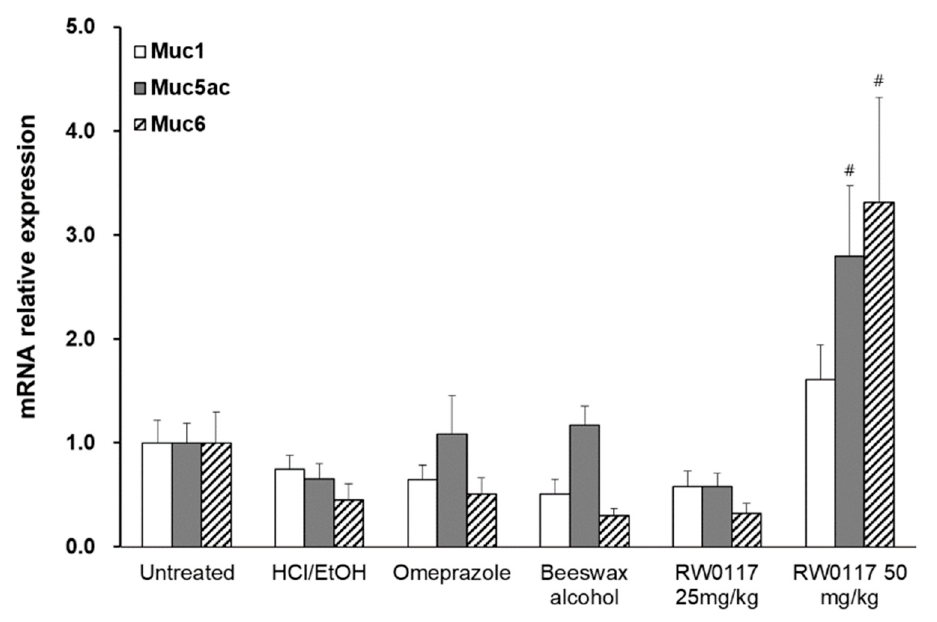
Figure 8. Analysis of mRNA expression of Muc1, Muc5ac, Muc6 in ulcer-induced rat stomach . Untreated: nontreated group, HCl/EtOH: HCl/EtOH-treated group, Omeprazole: omeprazole + HCl/EtOH-treated group, beeswax alcohol: beeswax alcohol 100 mg/kg + HCl/EtOH treated group, RW0117 25 mg/kg: RW0117 25 mg/kg + HCl/EtOH-treated group, RW0117 50 mg/kg: RW0117 50 mg/kg + HCl/EtOH-treated group. Statistical significance was determined using one-way analysis of variance (ANOVA) followed by Tukey’s post hoc test. # p < 0.05 vs. control group.